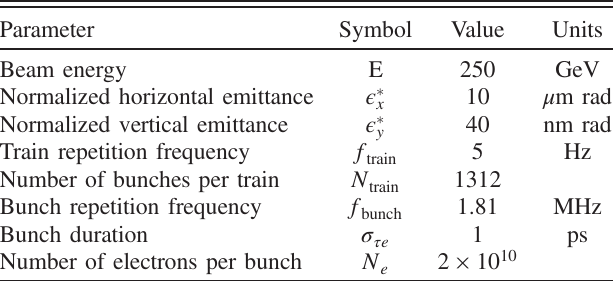
TABLE I. Nominal ILC BDS electron beam